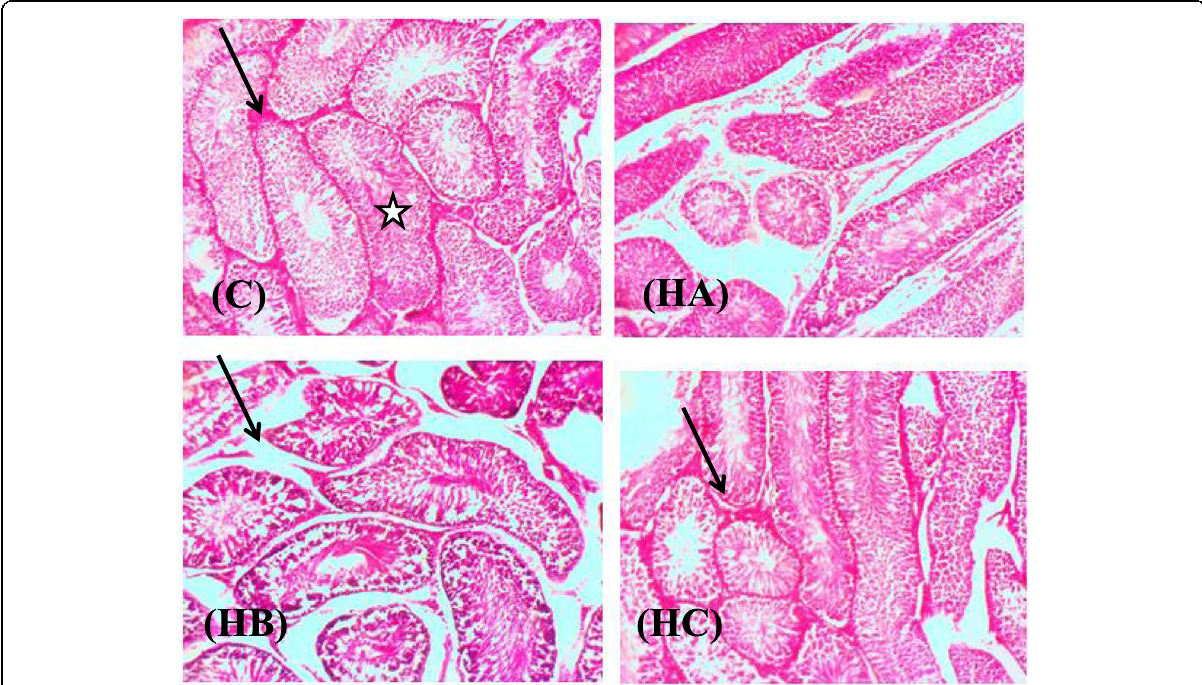
Fig. 3 Photomicrographs of the testis of male Wistar rats exposed to different doses of hexane soluble fraction of WILR. Control (C): normal testis showing the seminiferous tubules (star) and interstitium (black arrow). 200 μ g/kg (HA): loss of interstitium (arrow) and germ cells. 500 μ g/kg (HB): loss of interstitium (arrow) and erosion of germinal epithelium. 1000 μ g/kg (HC): loss of interstitium (black arrow). H&E ×